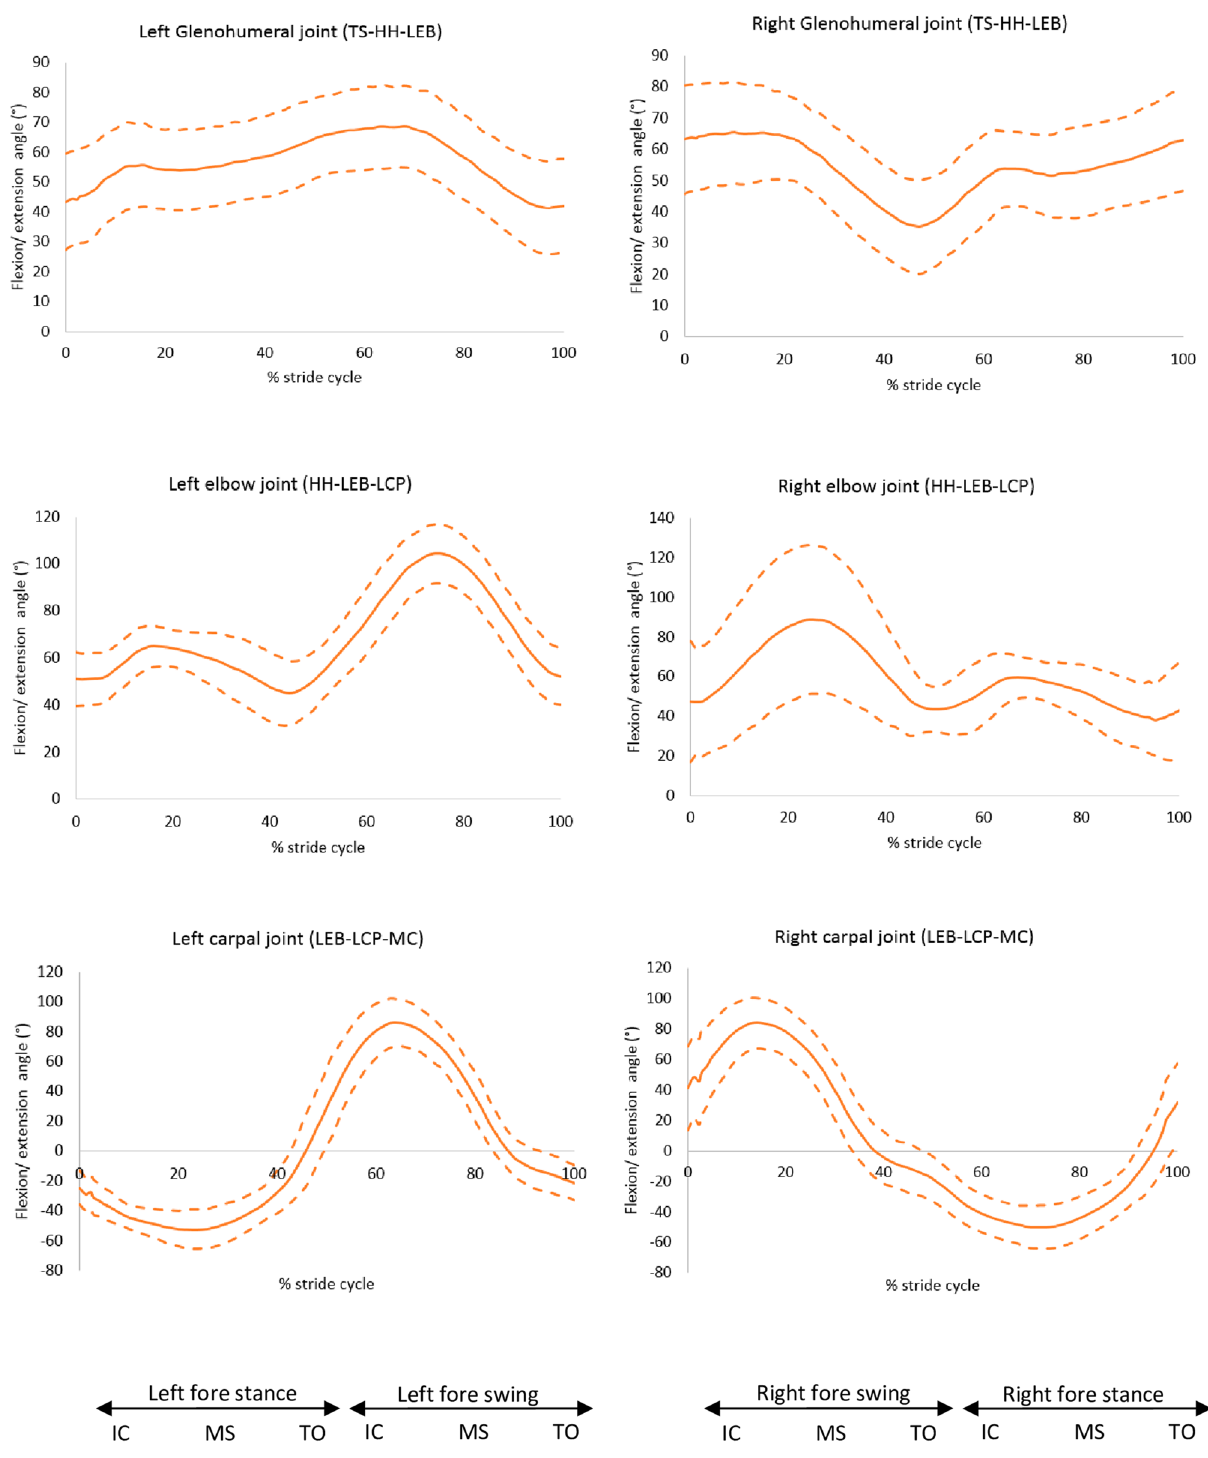
Figure 9. Flexion (positive) and extension (negative) angles for the forelimb joints, mean of 30 GSDs (solid line) and showing one standard deviation from the mean (dashed lines). Graphs are plotted for one stride cycle, showing initial contact (IC), Mid Stance (MS) and Toe Off (TO) for the left and right diagonals. Between brackets: marker names (Supplementary material 3,